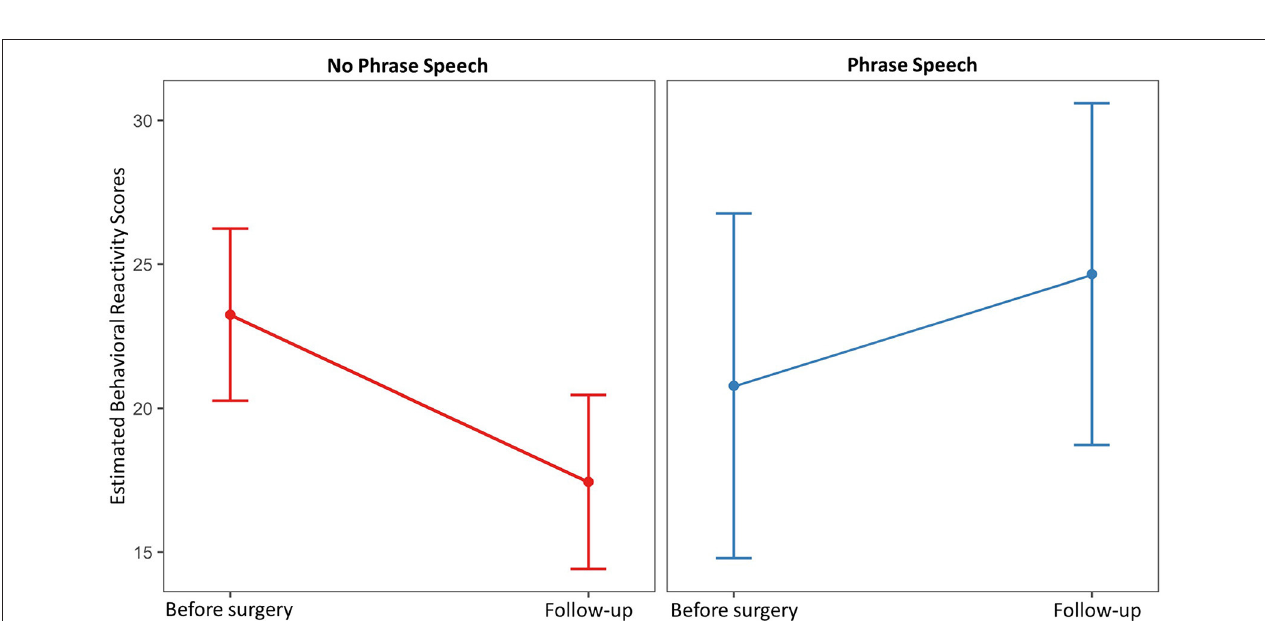
FIGURE 2 | Estimated marginal mean behavioral reactivity scores prior to surgery and at follow-up by child spoken language